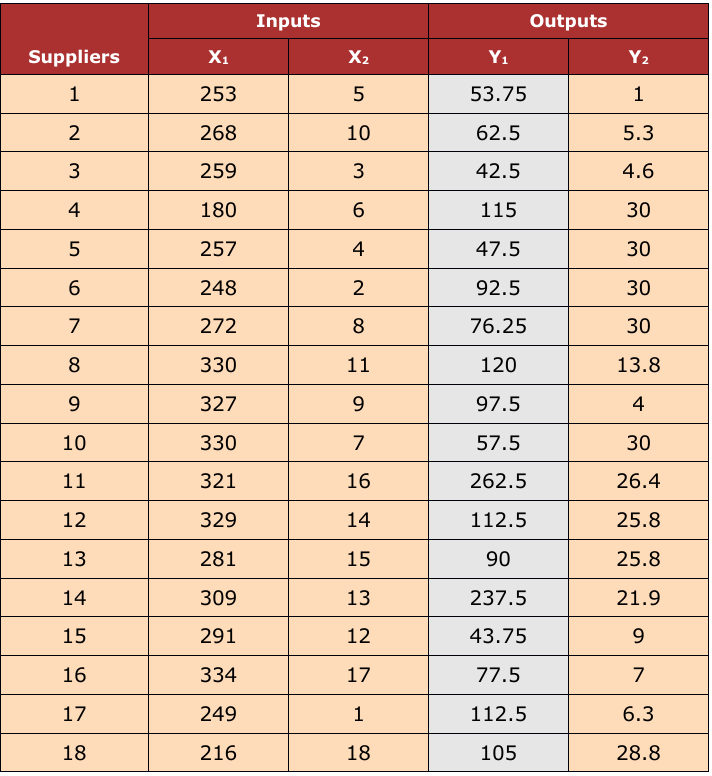
Table 2. Original values for α = 0.25